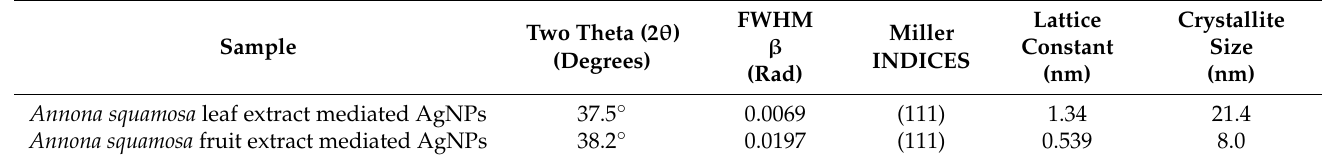
Table 1. Lattice parameter and crystallite size of synthesized